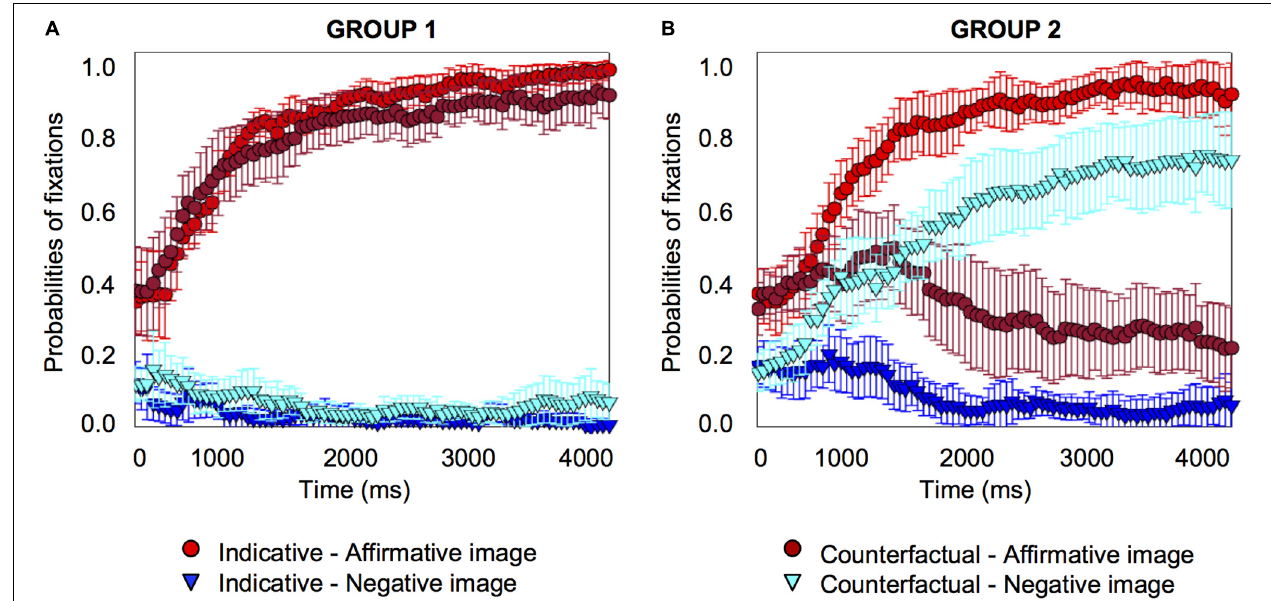
FIGURE 4 | Individual differences probabilities of fixations for indicative and counterfactual sentences for one subset group of 11 participants who looked at the affirmative image for counterfactuals (A) , and a second subset group of 12 participants who looked at the negative image only or at the affirmative and negative image for counterfactuals (B) in Experiment 1. Error bars are 95% confidence intervals within